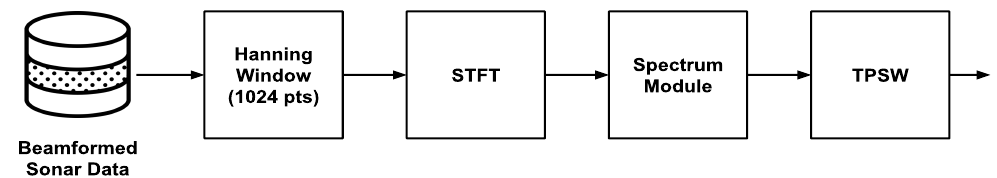
Figure 1. Block diagram of the LOFAR